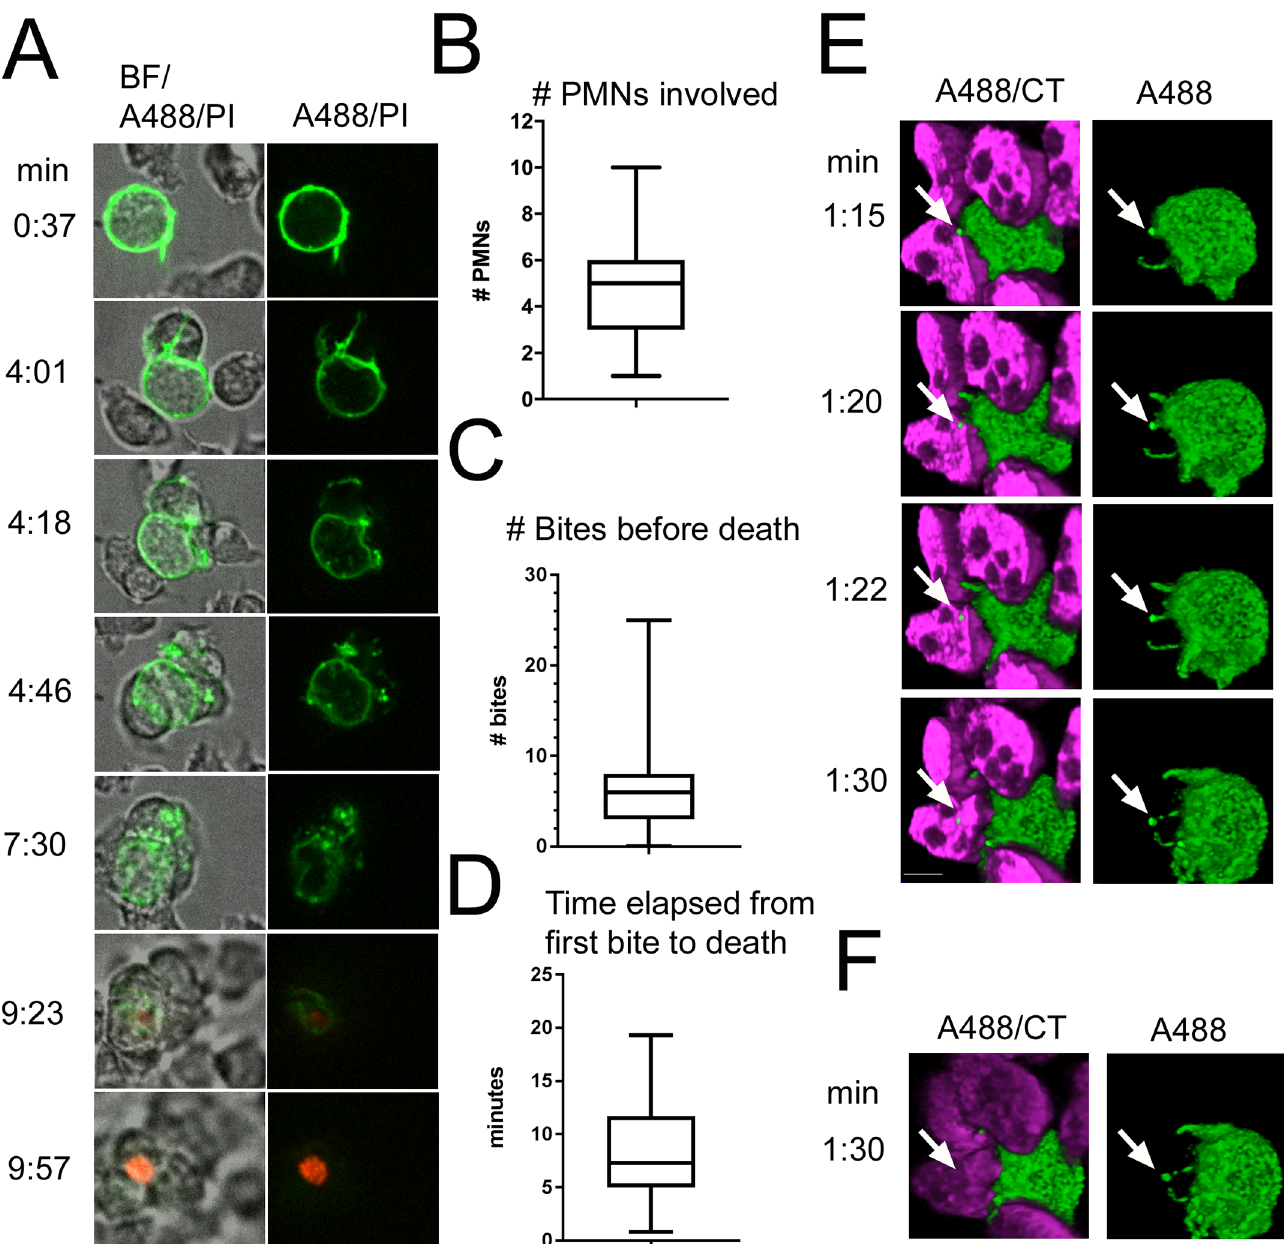
Fig 4. PMNs swarm and trogocytose T . vaginalis prior to T . vaginalis death. (A) Live imaging. Total T . vaginalis surface proteins were covalently linked with Biotin, stained with Streptavidin-Alexa-488 (A488, green), and cocultured with unlabeled PMNs at MOI 0.1 with 10 ug/ml PI in the media. Selected time points of 2D live video at 63X magnification of the interactions are shown. Images are representative of 96 parasite death events performed with PMNs from 11 different human donors. min. = minutes after parasites and PMNs were cocultured. Scale bar = 10 um. (B) and (C) Box and whisker plots showing distribution according to quartiles. (B) 96 videos of T . vaginalis death events from 11 donors’ PMNs were analyzed for the number of PMNs in contact with T . vaginalis before the parasite dies. (C) 96 videos from 11 donors’ PMNs were analyzed for the number of “bites” of T . vaginalis material transferred to PMNs before the parasite dies. (D) Videos in which the first “bite” was observable (19 videos from 7 donors’ PMNs) were analyzed for the time elapsed from when the first bite was taken until PI signal was observed in T . vaginalis . Underlying data can be found in S1 Data. (E) 3D live imaging. T . vaginalis surface was labelled with Alexa-488 as in (A) and cocultured with CT-labelled PMNs (magenta) at MOI 0.1 in the presence of 10 ug/ml PI. Z-stacks spanning 15 um were acquired every 1.5 seconds. Selected time points at 63x of PMN engulfment of T . vaginalis material before parasite death are shown with 3D reconstruction of deconvolved images. Images are clipped midway through the z-axis to visualize the inside of the PMNs. Scale bar = 5 um. White arrow indicates “bite” of T . vaginalis that is uptaken by PMNs. (F) Last timeframe of (E) is shown without any clipping of the z-axis. Data in E and F are representative of at least 3 replicates each from 3 donors and 3 independent experiments. BF, bright field; CT, Cell Tracker; MOI, multiplicity of infection; PI, Propidium Iodide; PMN, polymorphonuclear cell.